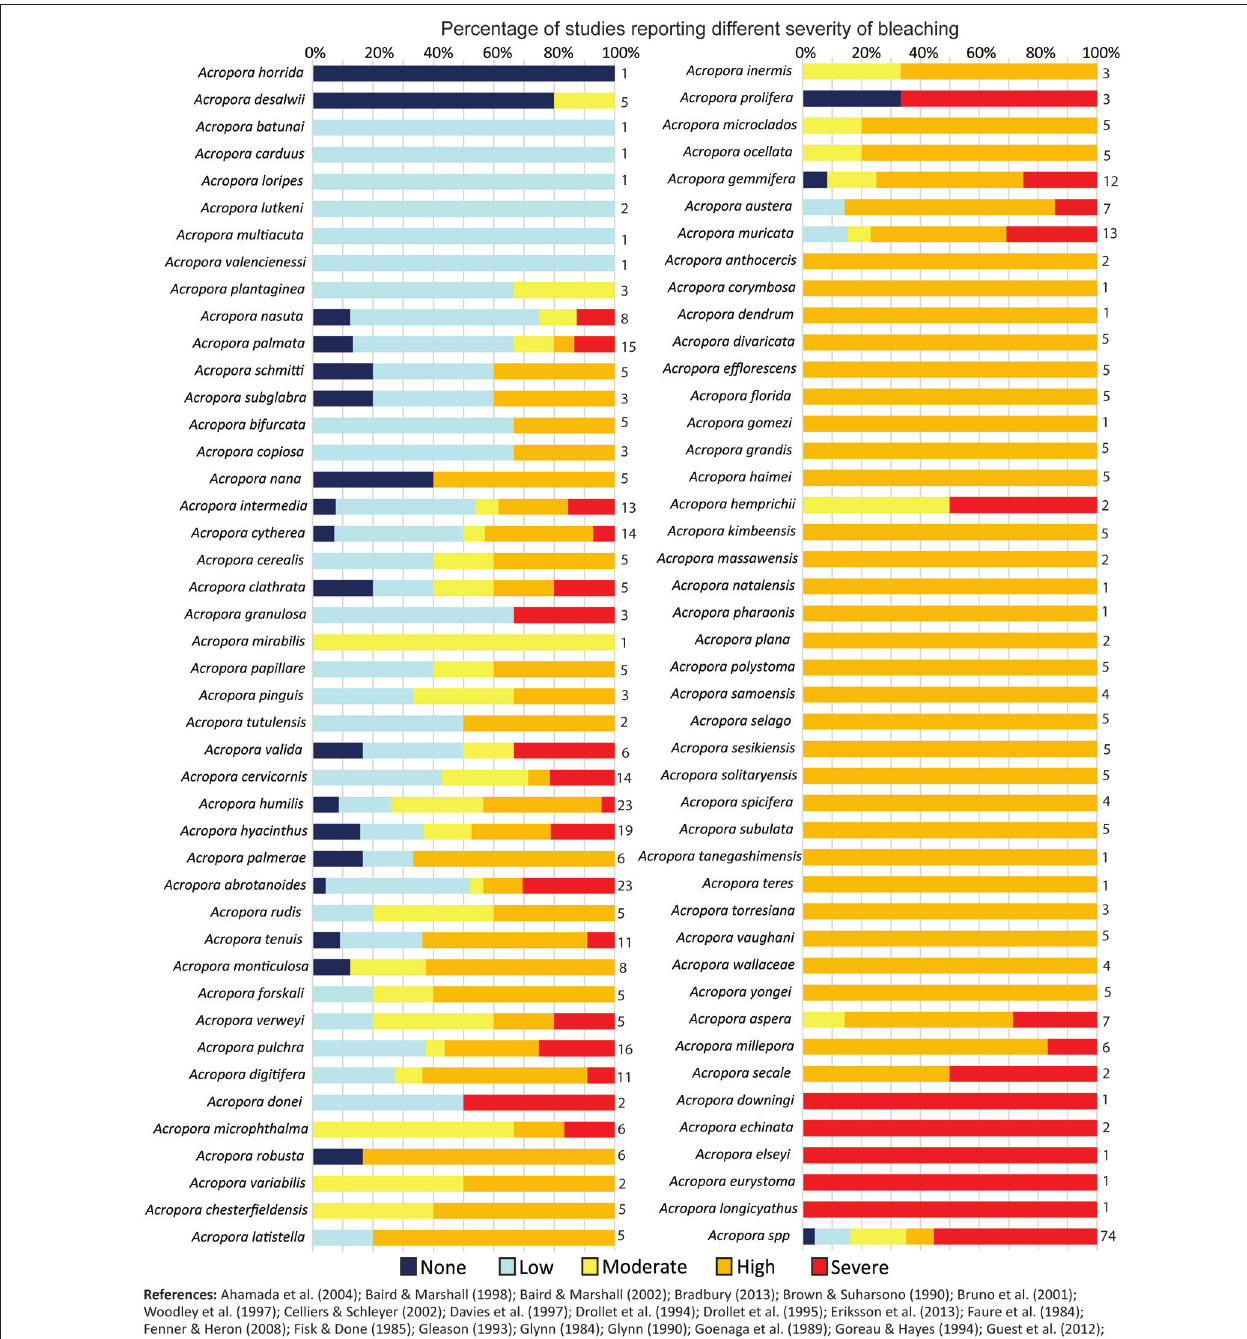
FIGURE 6 | Records of bleaching severity for different Acropora species compiled from the literature. Bars show the percentage of records in the literature for each species in each bleaching severity category ( N = 527) and numbers adjacent to bars indicate number of records per species.